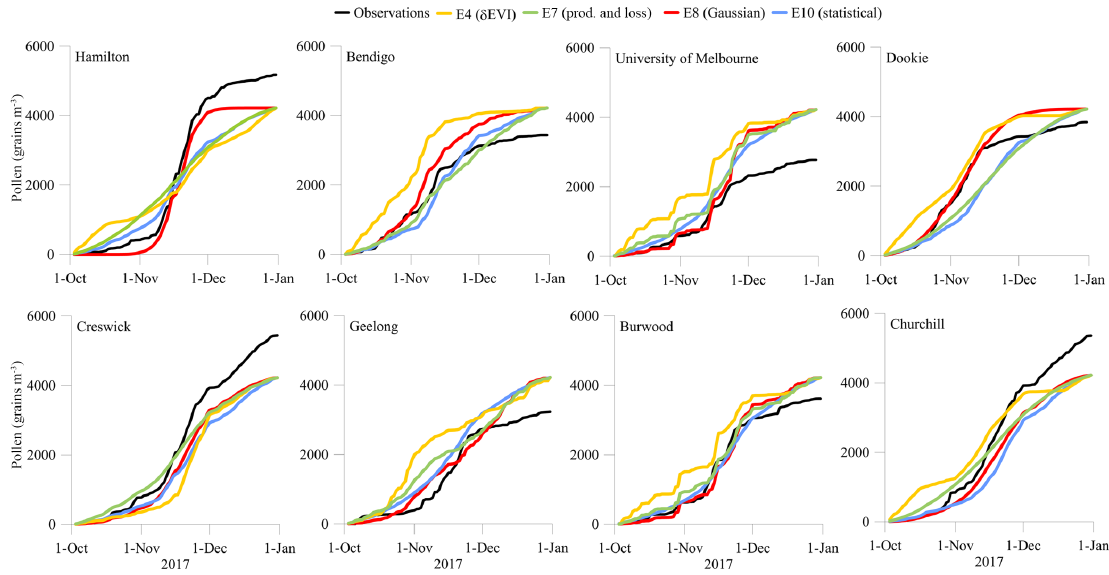
Figure 8. Cumulative time-series for pollen across the 2017 season. Sites arranged from west to east. Table 4. The number of days the model predicts a particular observed pollen category for E8 (left) and E10 (right). Data from all Victorian sites are combined. Bold text highlights where the model captures the correct observed